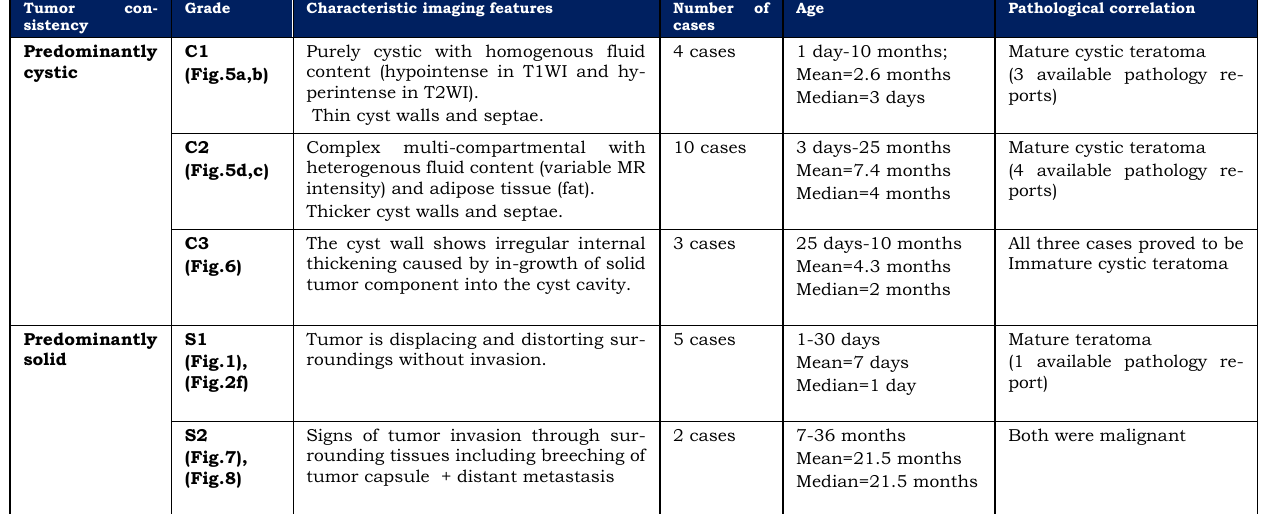
Table 2: Grading of cases of sacrococcygeal teratoma according to tumor